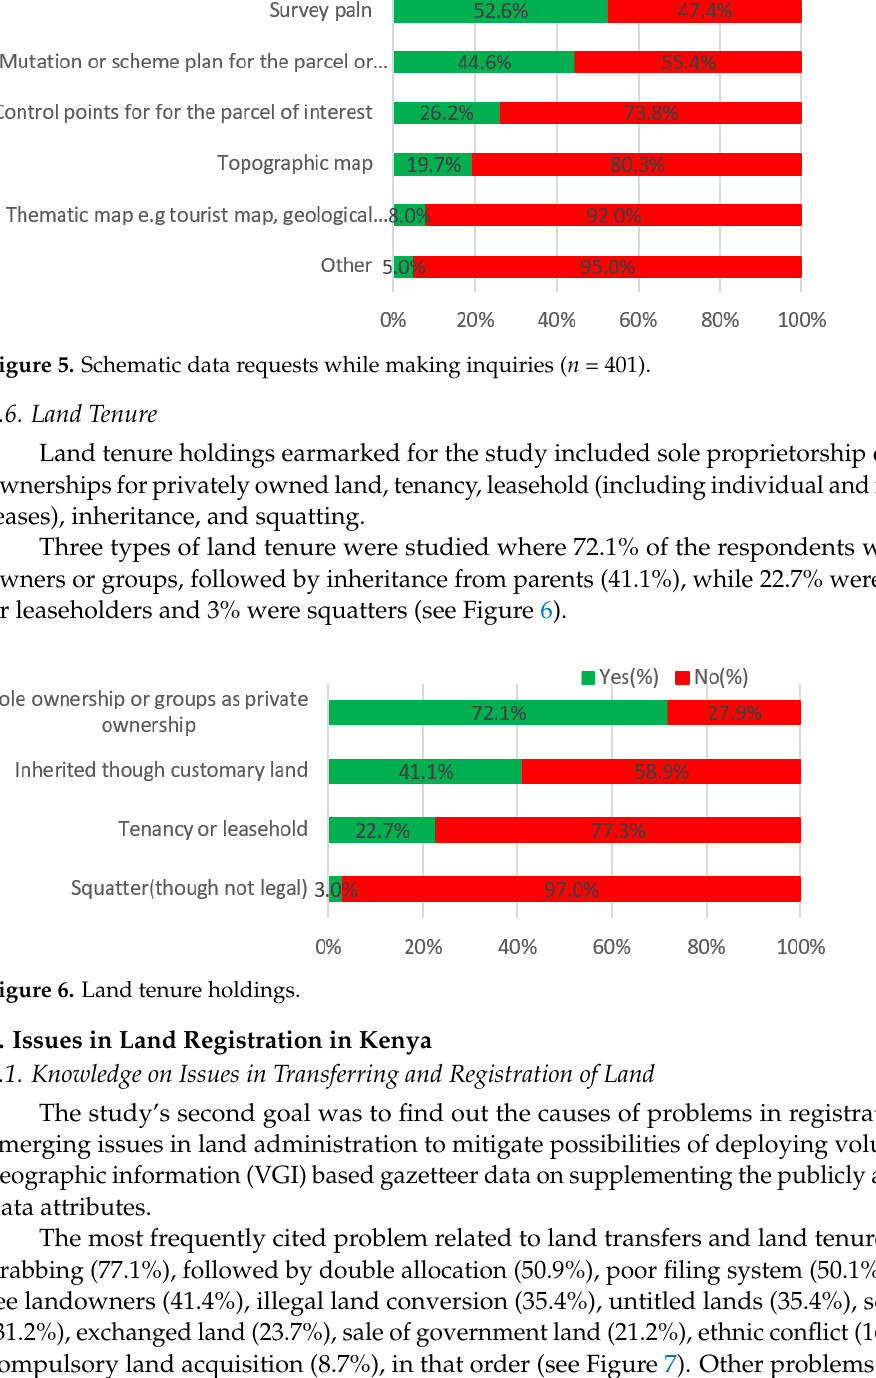
Figure 5. Schematic data requests while making inquiries ( n = 401).